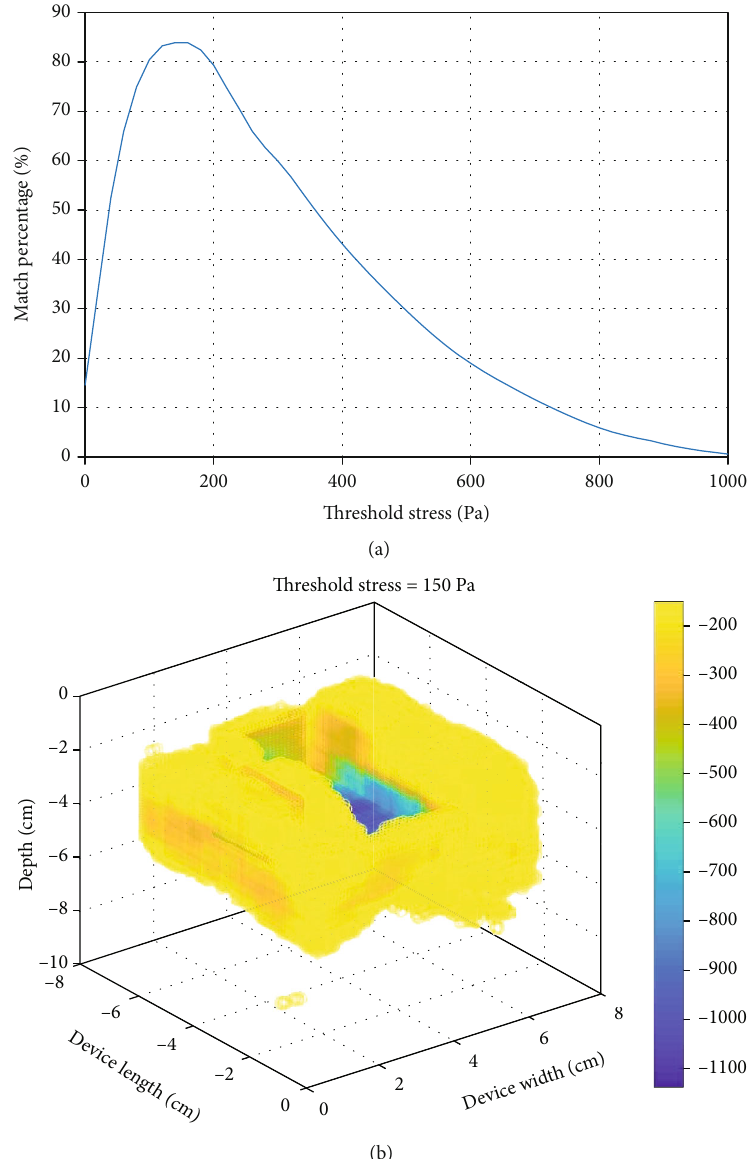
Figure 11: Trend of change between match percentage and threshold stress (a) and the in fl uence zone with the largest match percentage